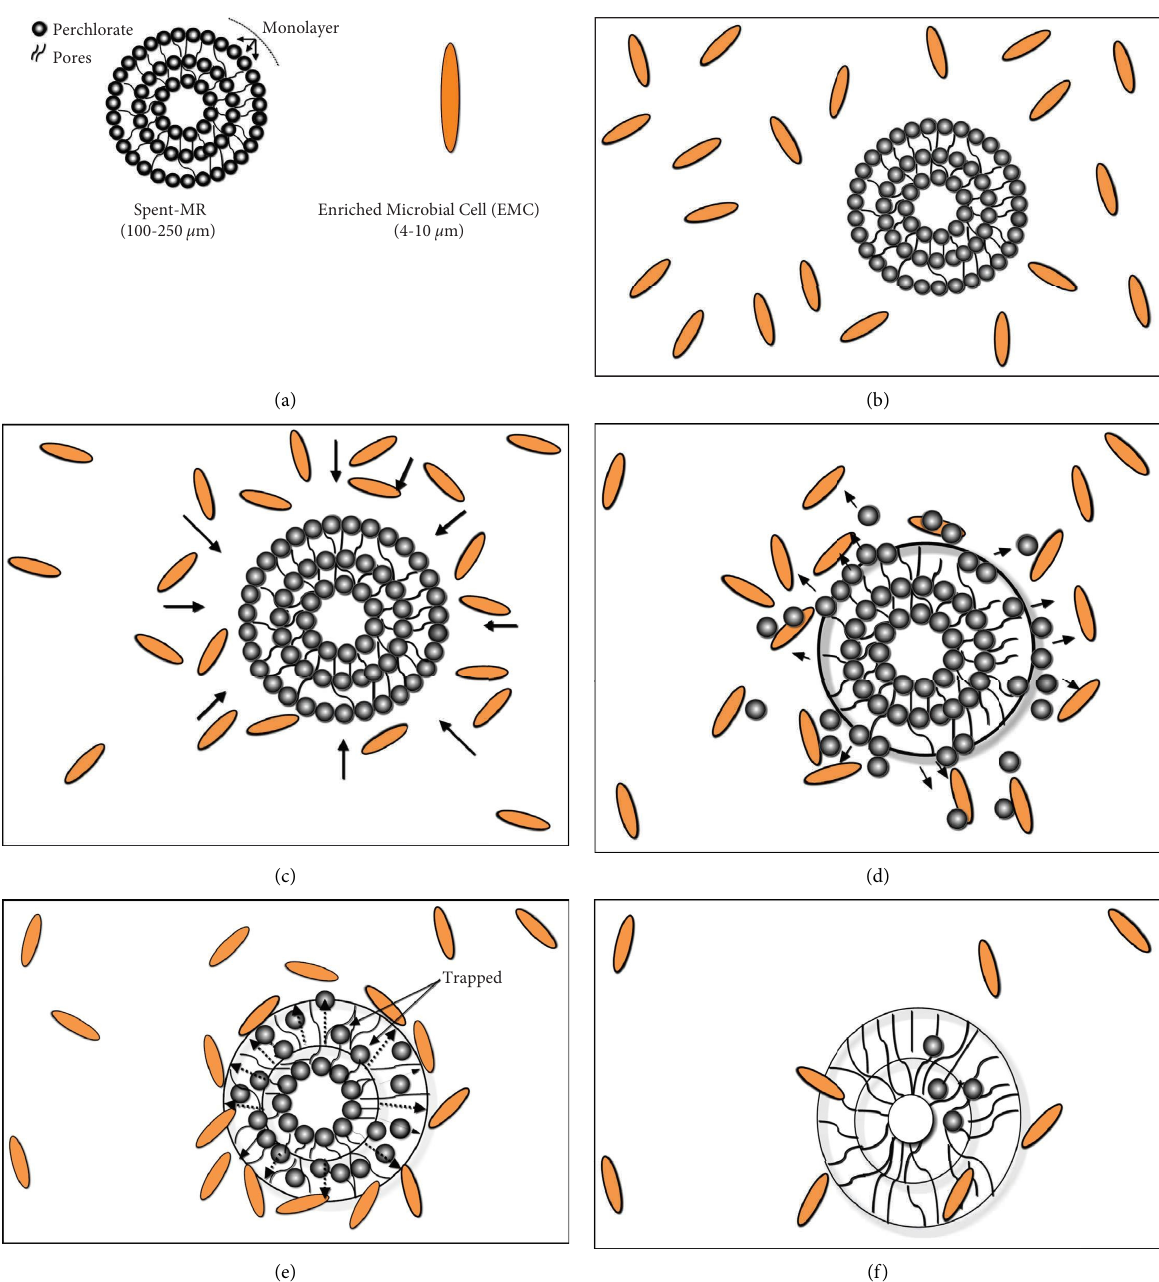
Figure 4: Shrinking core model of perchlorate biodegradation from spent MR (drawn in SmartDraw). (a) Stationary phase (0–24h): negligible removal, putatively due to EMC reacclimatization. (b) Transport of EMC from the bulk fuid to the MR surface. (c) EMC utilization of perchlorate at readily available monolayers (limited by reduction reaction rate). (d) Subsequent EMC utilization of perchlorate beneath the monolayer, which has to difuse through pores and has reduced availability (smaller radius; trapped in pores). Removal slows, becoming dependent on the perchlorate difusion rate. (e) Continued decline in the removal rate until all available perchlorate has been removed. (f) Te removal rate is reduced considerably until it reaches a minimum. Trapped perchlorate is not